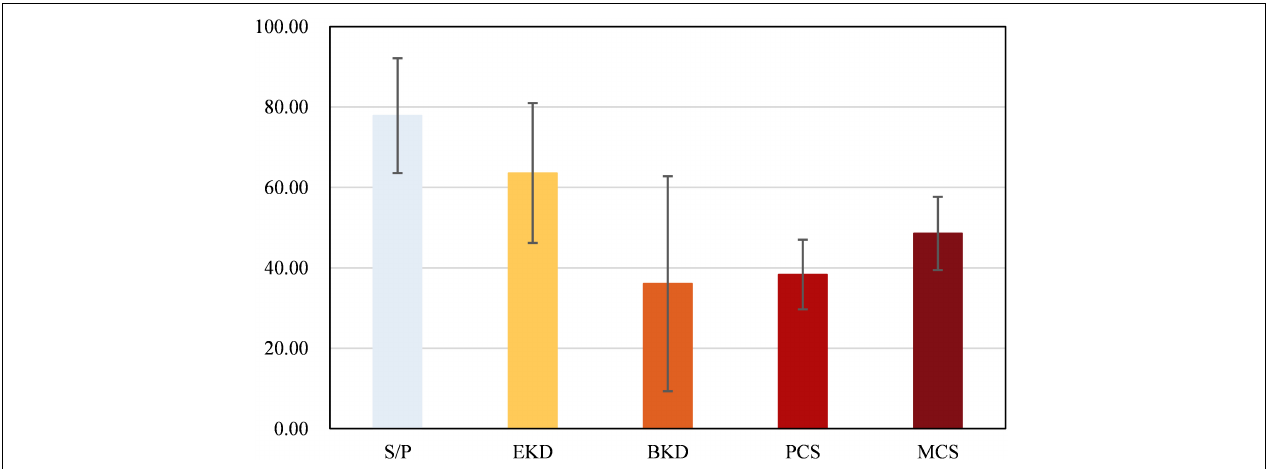
FIGURE 1 | Scores on the five dimensions of the kidney disease quality of life (KDQOL) scale. SP, symptom/problem; EKD, effects of kidney disease; BKD, burden of kidney disease; PCS, physical component summary; MCS, mental component